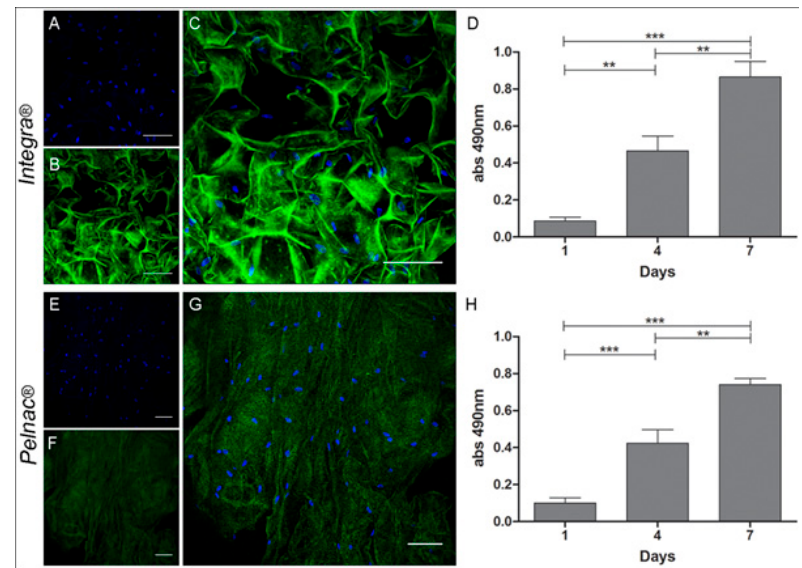
Figure 7. 3D cultures of human SD-MSCs in different polymeric materials ( A – D ) Integra and ( E – H ) Pelnac. Confocal microscopy of SD-MSCs stained with nuclear staining (DAPI), ( B , F and C , G ) are dermal substitutes from each group (green autofluorescence) and merged images respectively. ( D , H ) MTS cell viability assay of SD-MSCs cultured in Integra and Pelnac, respectively. *** p < 0.001, ** p < 0.01. Reprinted under open access distribution license from [97].